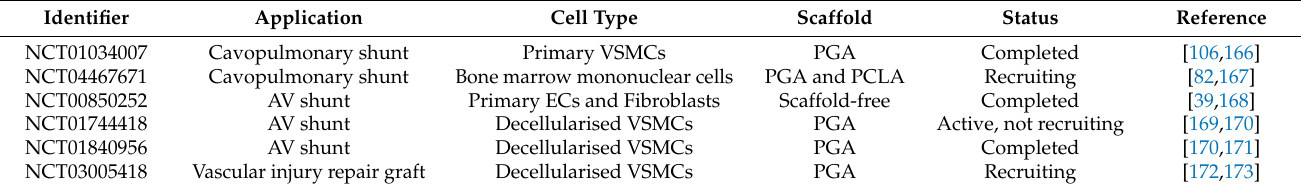
Table 4. TEVGs that have reached clinical